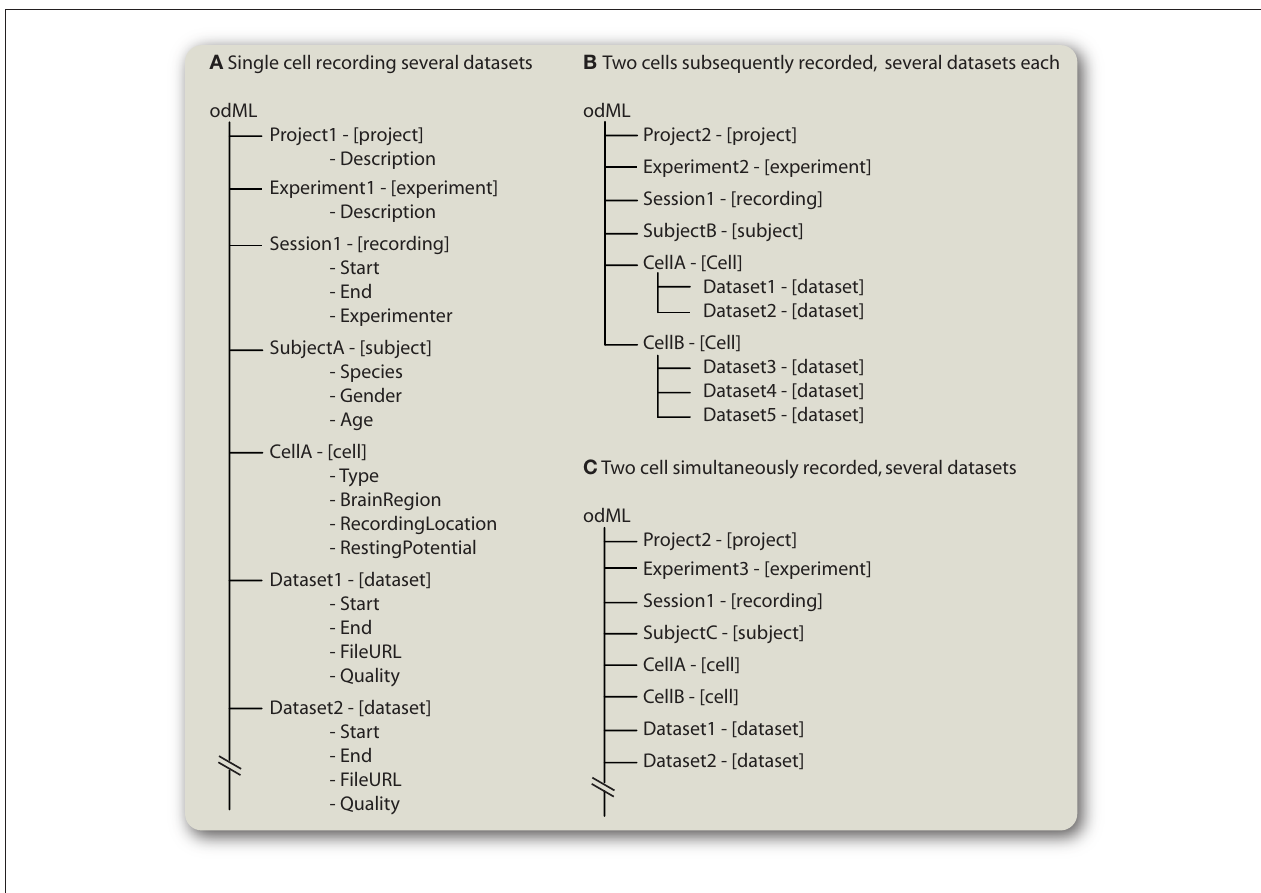
several datasets have been recorded in a number of cells from the same subject. (C) Description of simultaneous recordings of two cells. Note: For clarity Properties are omitted in (B,C) . Sections are shown in the form “name